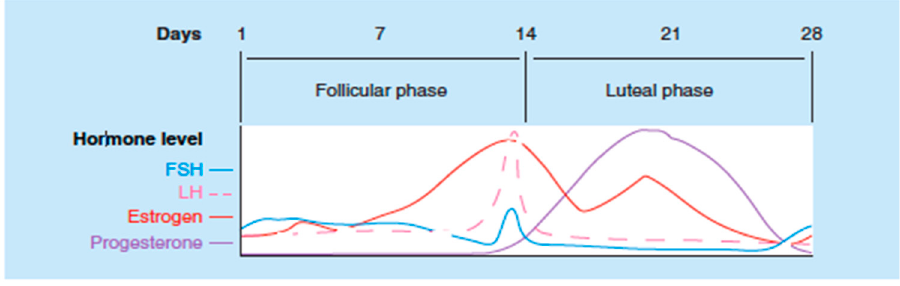
Figure 2. Relationship of steroid and gonadotropin hormones during the normal menstrual cycle. Adapted from Pain and sex hormones: a review of current understanding [1].